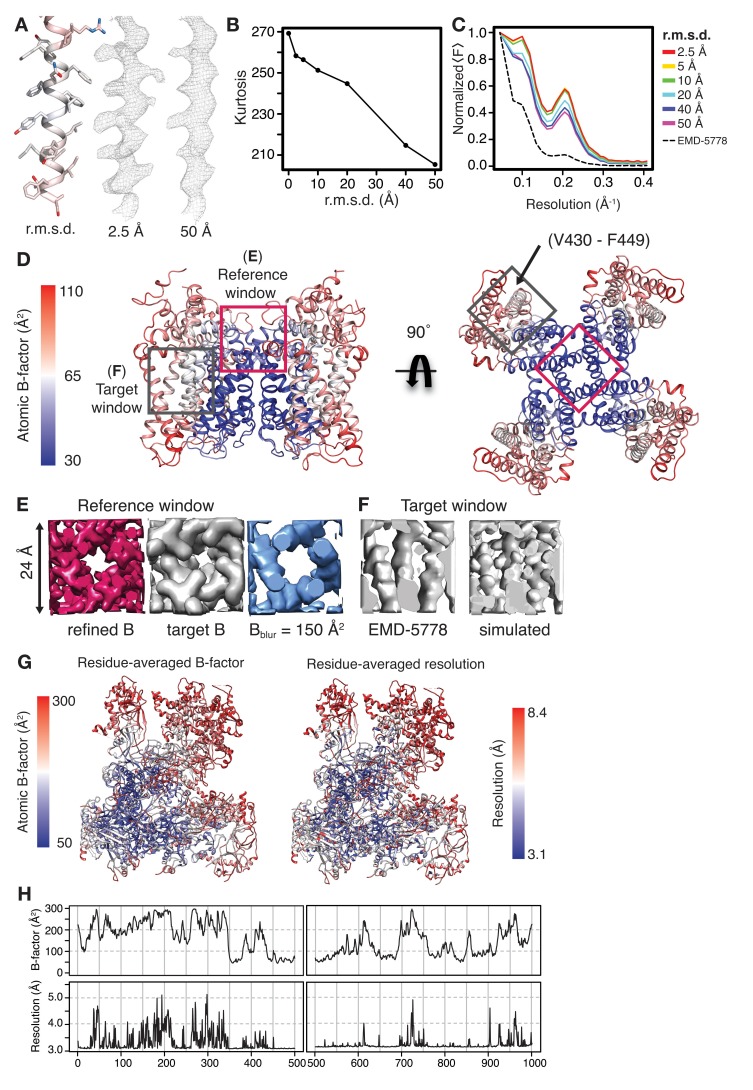
Assessment of coordinate and B-factor perturbation on LocScale densities and the relationship of atomic B-factors to local resolution.(A) Densities for TRPV1 residues V430-F449 (left, shown in cartoon/stick representation) obtained after perturbing initial coordinates of the reference model by 2.5 Å (middle) or 50 Å (right). Atoms in the unperturbed model (left) are colored according to B-factor as in (C). (B) Map kurtosis of LocScale maps as a function of coordinate perturbation (in Å r.m.s.d. from the initial coordinate model) used to compute the reference map for scaling. Kurtosis as a measure for sharpness of the map decreases with increasing model perturbation. (C) Radial amplitude profiles of the LocScale maps obtained after coordinate perturbation of the reference model. (D) Side (left) and top view (right) of the TRPV1 transmembrane region shown in cartoon representation. Regions used as reference (magenta) and target windows (grey) for scaling are highlighted by boxes. Atomic B-factors are mapped onto the cartoon model (scale bar shown on left). (E) Density for reference window shown in (D) simulated with the refined average B-factor from the atomic model contained in the reference window (left, magenta), simulated with the B-factor estimated for the target window from (D) (grey, middle) and simulated after blurring the refined B-factor by a 100 Å2 (blue, right). (F) Density for target window as in the unsharpened map (EMD-5778, left) and the corresponding density window simulated from the model in (D) (gray, right). (G) Comparison of residue-averaged B-factor (left) and local map resolution (right) mapped onto a cartoon representation of Pol III. The spatial distribution of atomic B-factors follows that of local resolution, with low B-factors (high resolution) in the core and high B-factors (low resolution) at the periphery. (H) Stacked diagrams of atomic B-factors (top) and local resolution (bottom) for two residue stretches of Pol III. Both quantities show correlating profiles of maxima and minima.